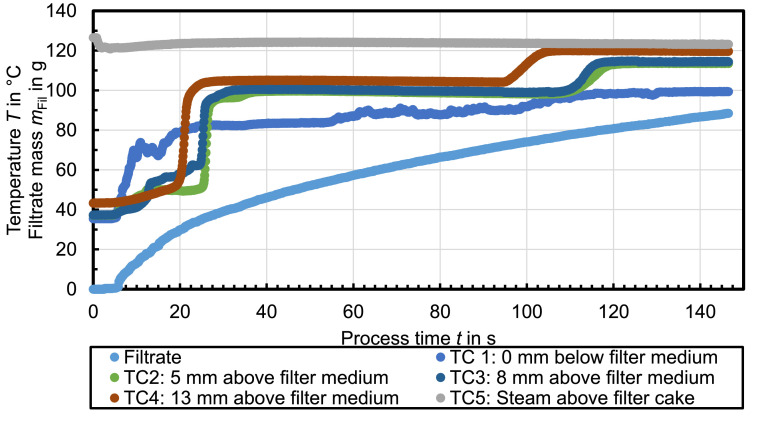
Celite®512 & toluene (Δp = 1.3 bar, Tst = 120°C, hFC = 20 mm); RM = 20 %, rC = 3 × 1012 1/m²